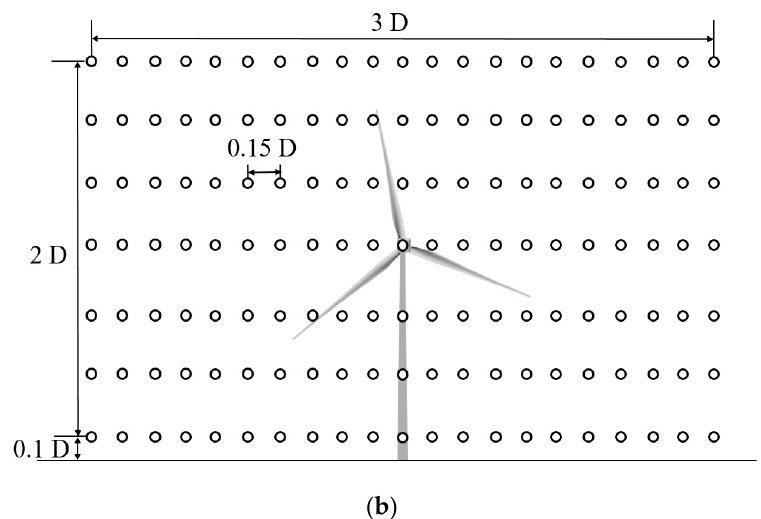
Figure 3. ( a ) Schematic diagram of the experimental setup and measurements in the wind tunnel; ( b ) the layout of the measurement positions.